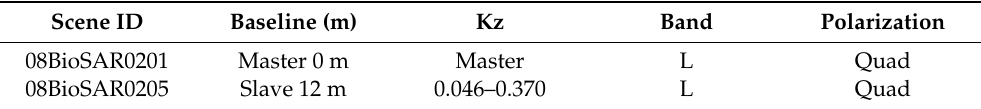
Figure 3. The extent of the study area and the several products included in the BioSAR 2008 dataset. ( a ) The red pentagram in the upper right corner of the thumbnail depicts the location of the study area in Sweden. The red rectangle region shows the SAR image. The green and yellow polygons represent the 31 forest stands in the red rectangle region; the four yellow polygons represent the forest stands employed in this study. ( b ) The green background image is a Lidar image with a grid size resampling of 1m*1m. Pauli ‐ basis image is the extent of SAR images. The Pauli ‐ basis image (on the left) shows the locations of the four forest stands. The shape of four forest stands on the Pauli ‐ Table 2. BioSAR 2008 L-band PolInSAR data specific parameter information. The sceneIDs of master basis image is shown on the right. All products on the map are geocoded to WGS84 UTM Zone 34N. and slave images are 08BioSAR0201 × 1 and 08BioSAR0205 × 1, respectively. Scene ID Baseline (m) Polarization 08BioSAR0201